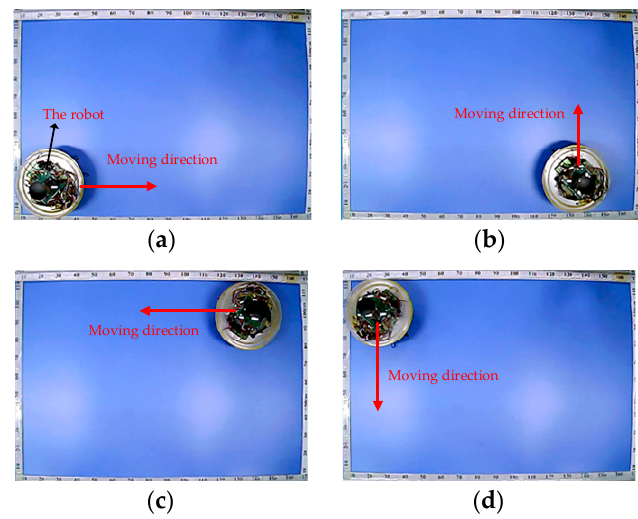
Figure 19. Snapshots of waypoint tracking (view of the global camera). ( a ) at point A; ( b ) at point B; ( c ) at point C; ( d ) at point D.